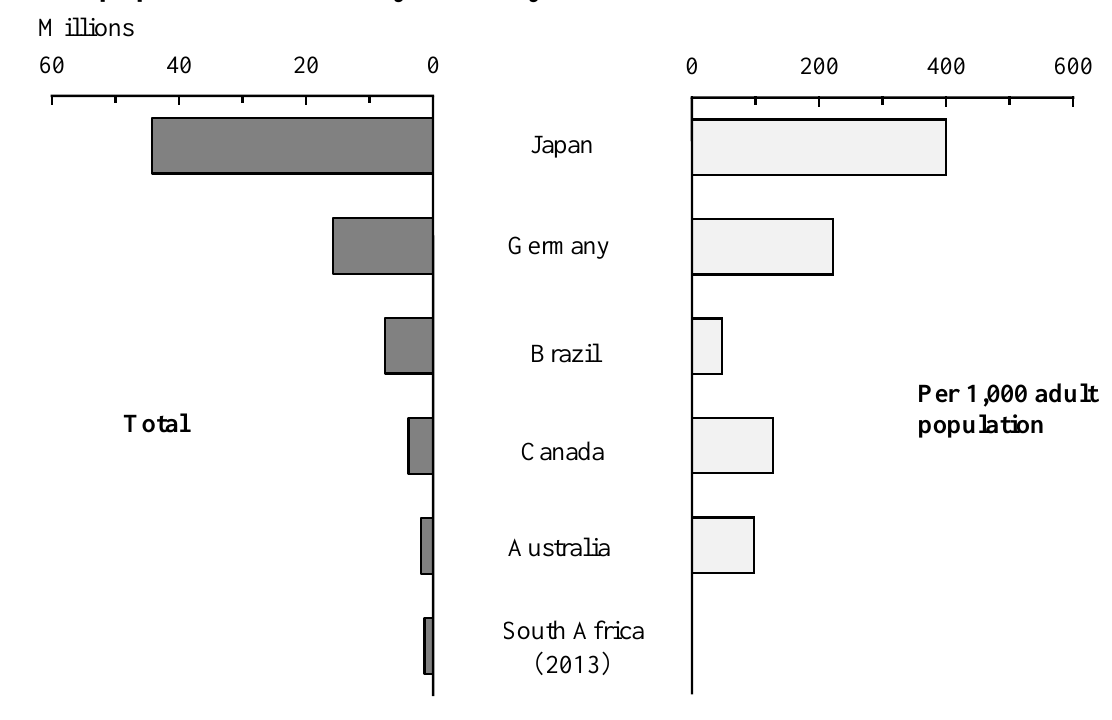
Source: World Association of Newspapers and News